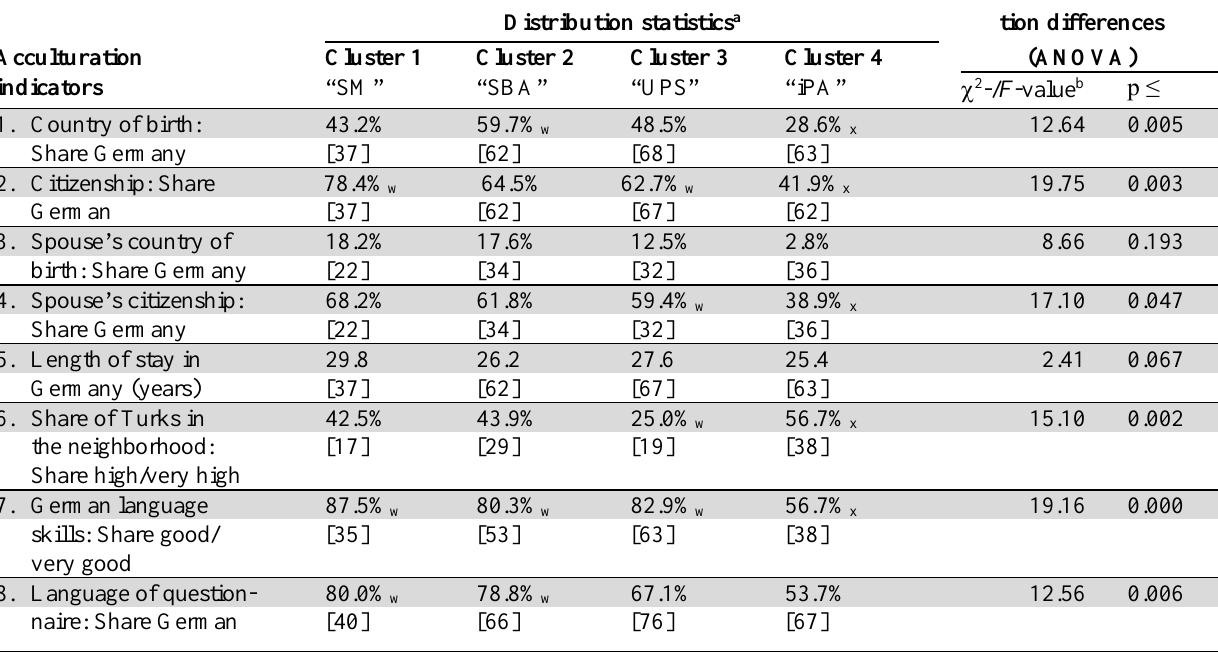
Table 5 Comparisons of acculturation indicators across the four preference